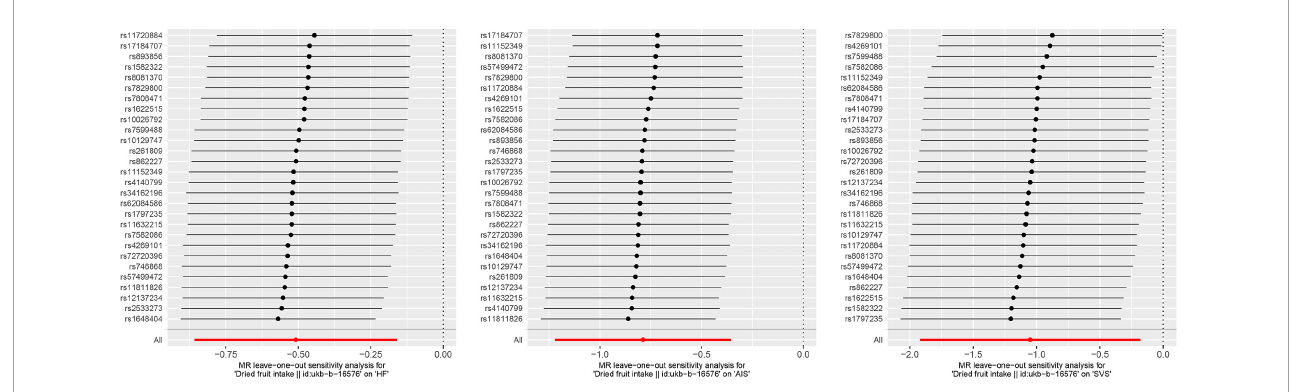
FIGURE4 Leave-one-out analysis for dried fruit intake on heart failure (HF), any ischemic stroke (AIS), and small vessel stroke (SVS).